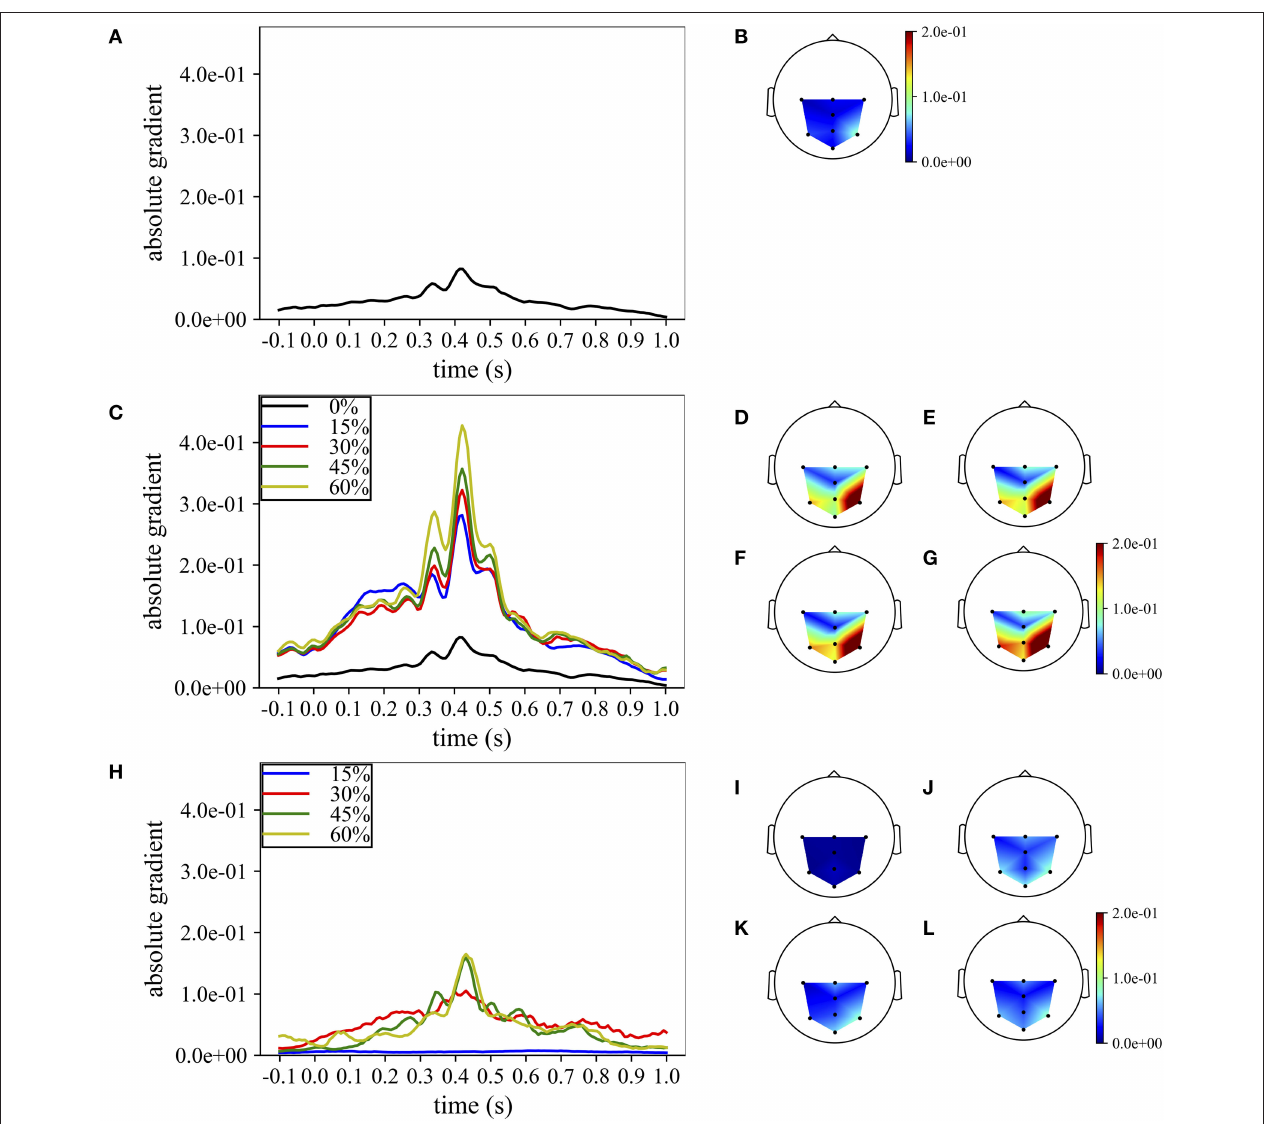
FIGURE 7 | Grand average temporal and spatial absolute representations of MS-EEGNet trained on dataset 1 for a representative participant and session, adopting the LOSO, TL-WS, and WS strategies. In particular, the representations obtained using the LOSO strategy in the temporal and spatial domains are reported in (A,B) , respectively. The representations obtained using the TL-WS strategy in the temporal and spatial domains are reported in (C) (colored lines) and (D–G) , as the percentage of training examples of the new participant increased (15, 30, 45, 60%, from D–G ). The representations obtained using the WS strategy in the temporal and spatial domains are reported in (H) (colored lines) and (I–L) , as the percentage of training examples of the participant increased (15, 30, 45, 60%, from I–L ). Note that in order to maintain the same scale across the strategies in the spatial absolute representations, in (D–G) , the maximum gradient value represented (2.0e − 1) was below the real maximum gradient value (3.3e − 1), saturating the value in particular around